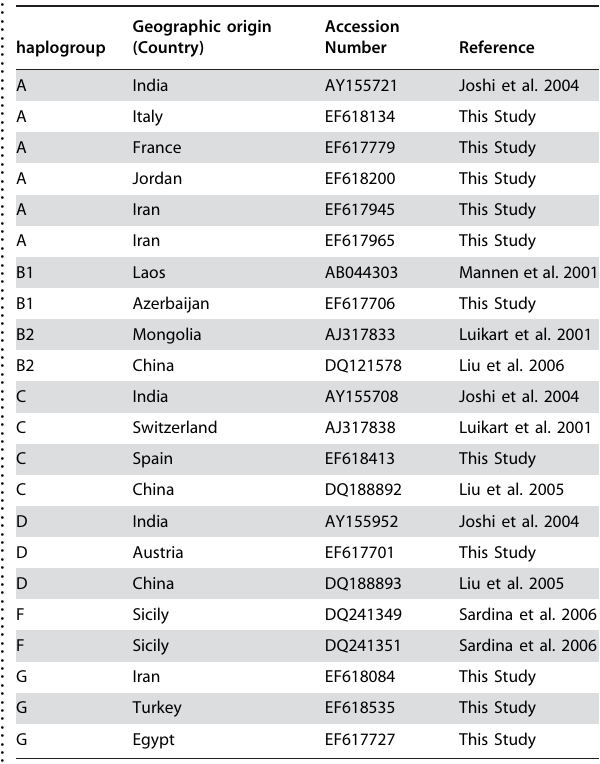
Table 5. The 22 reference individuals of the 6 domestic